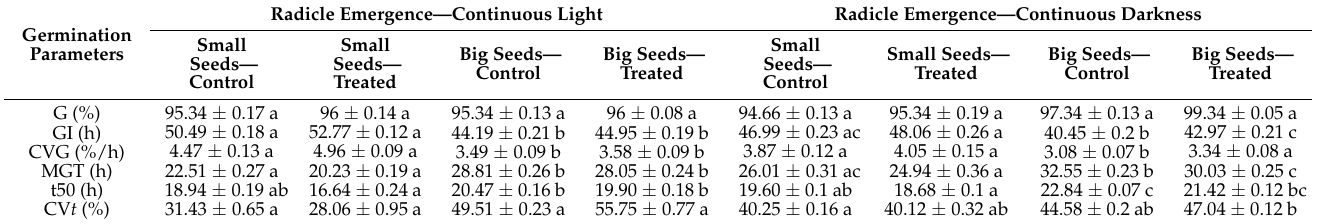
Table 4. EMF effects on germination parameters for radicle emergence (complete germination) of small and big seeds of winter wheat, in control conditions, and after EMF